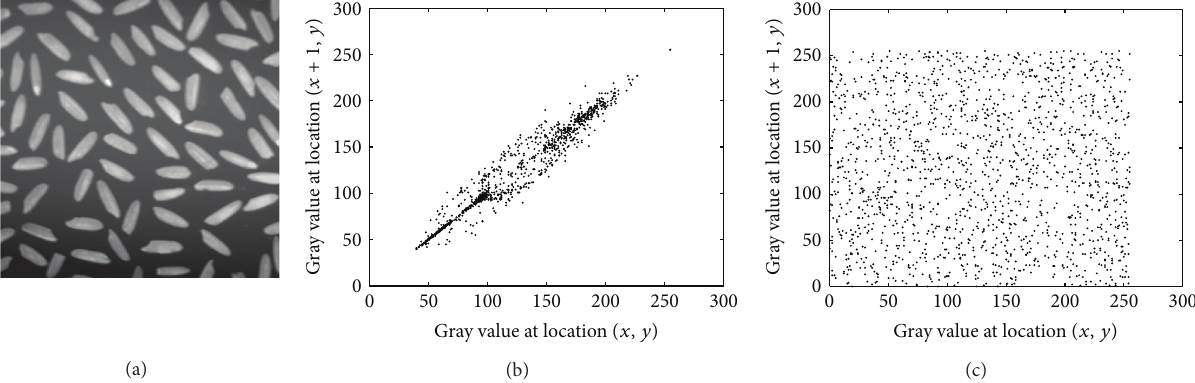
Figure 4: Correlation of two horizontally adjacent pixels in (a) plain-image, (b) correlation of (a), and (c) correlation of the cipher-image.